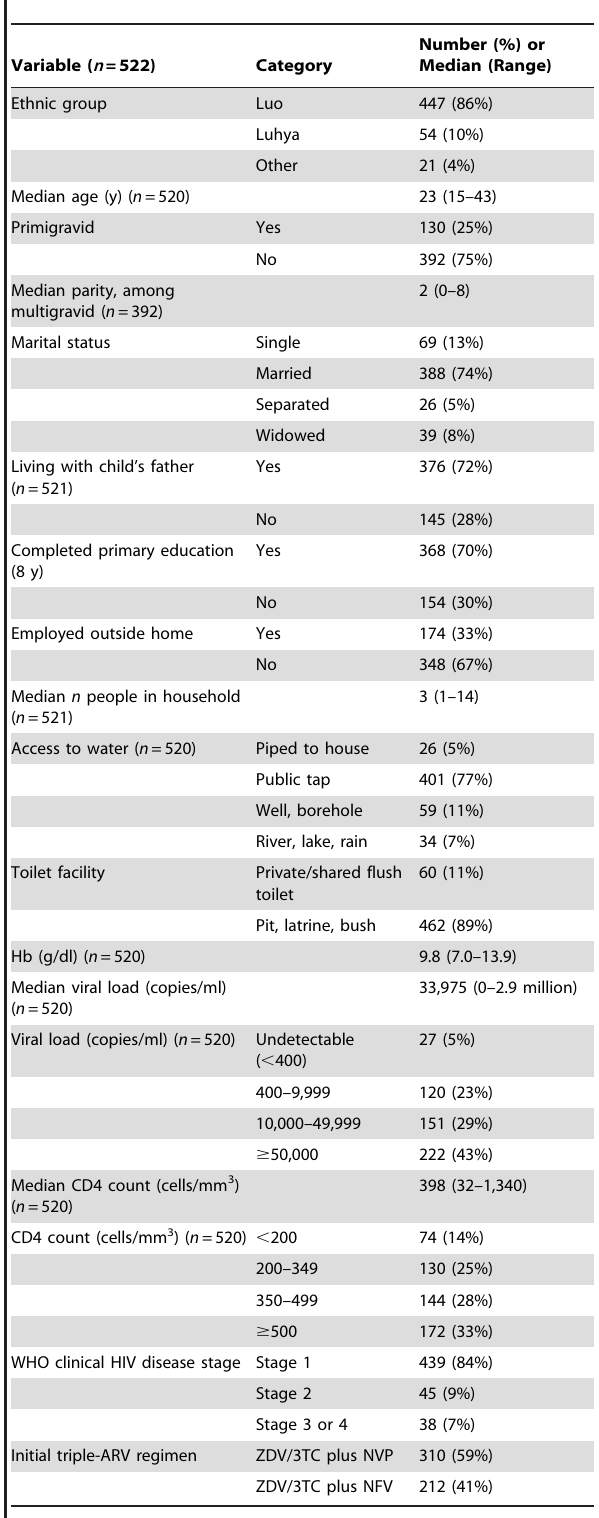
Table 1. Maternal baseline sociodemographic, clinical, and laboratory